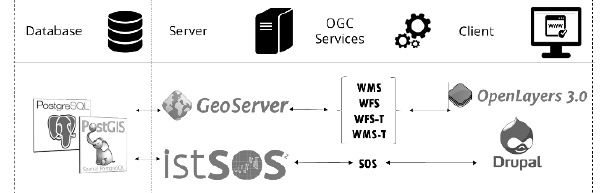
Figure 3. Red-Thai Binh rivers system geoportal architecture